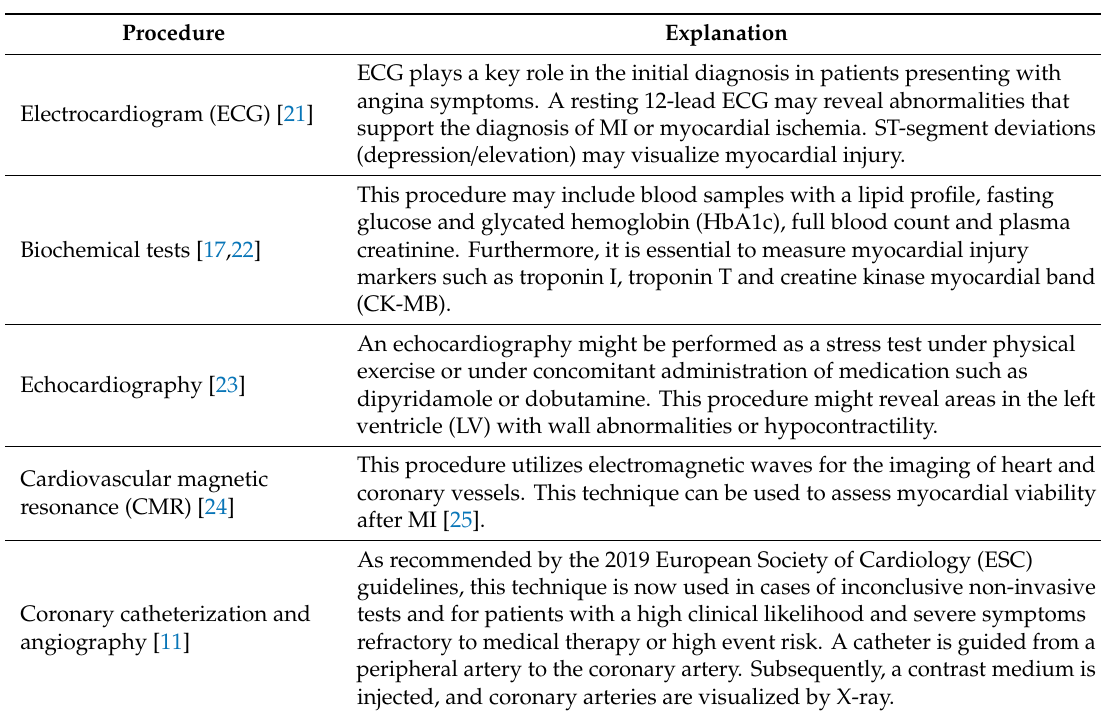
Table 2. Diagnostic tools for the diagnosis of